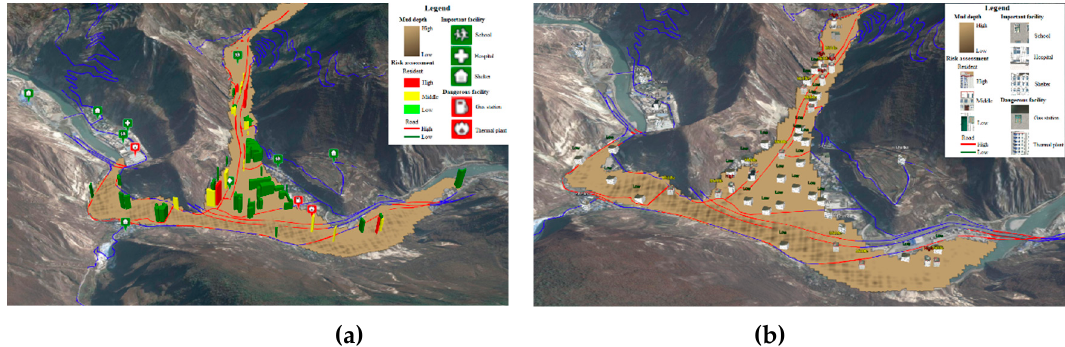
Figure 12. Tests of the difference between scene 1 and scene 2 on cognition efficiency: (a) Scene 1; and (b) scene 2.